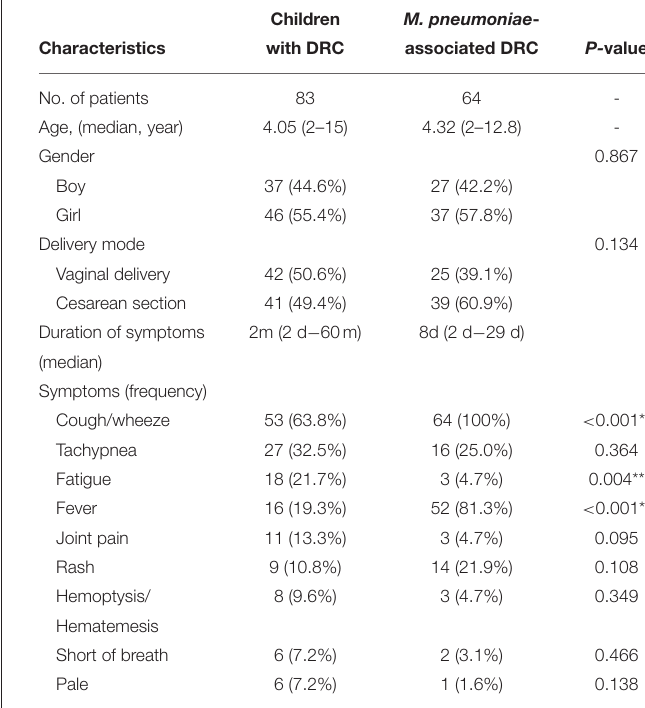
TABLE 1 | Clinical characteristic of 83 children with diffuse radiological changes